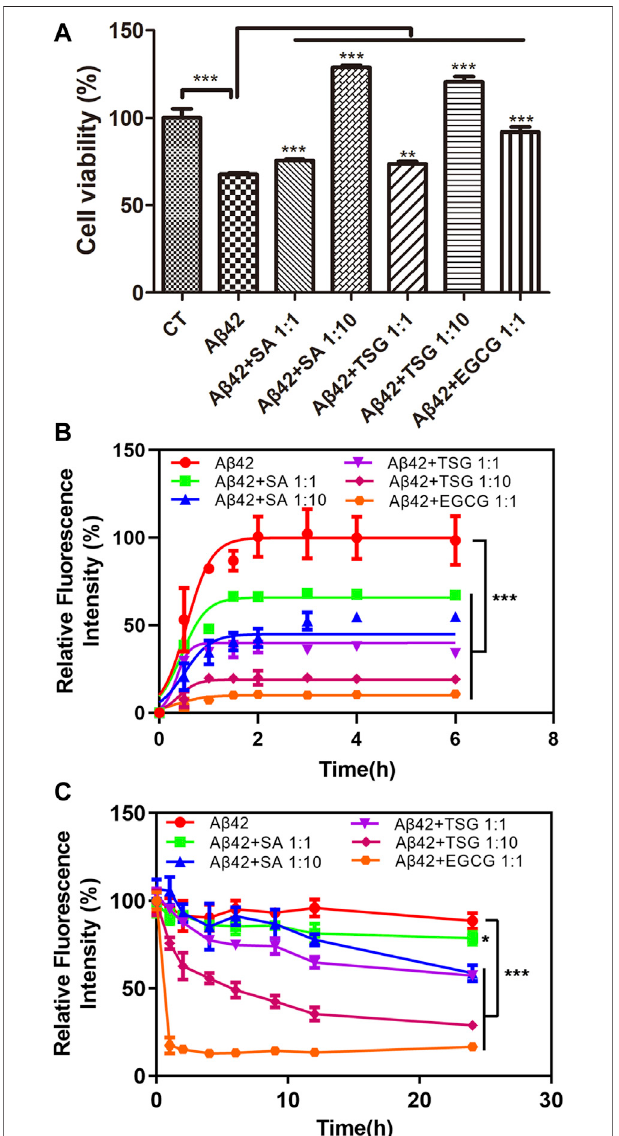
FIGURE 2 | Effects of equimolar EGCG, SA, TSG, and 10-fold SA, TSG on the cytotoxicity and aggregation of A β 42. (A) The effects of equimolar and 10-fold SAand TSGon A β 42cytotoxicity; (B) The effects ofequimolarEGCG, SA, TSG and 10-fold SA, TSG on the aggregation of A β 42; (C) The effects of equimolar EGCG, SA, TSG and 10-fold SA, TSG on the disaggregation of A β 42 fi brils. **p < 0.01, ***p < 0.001.